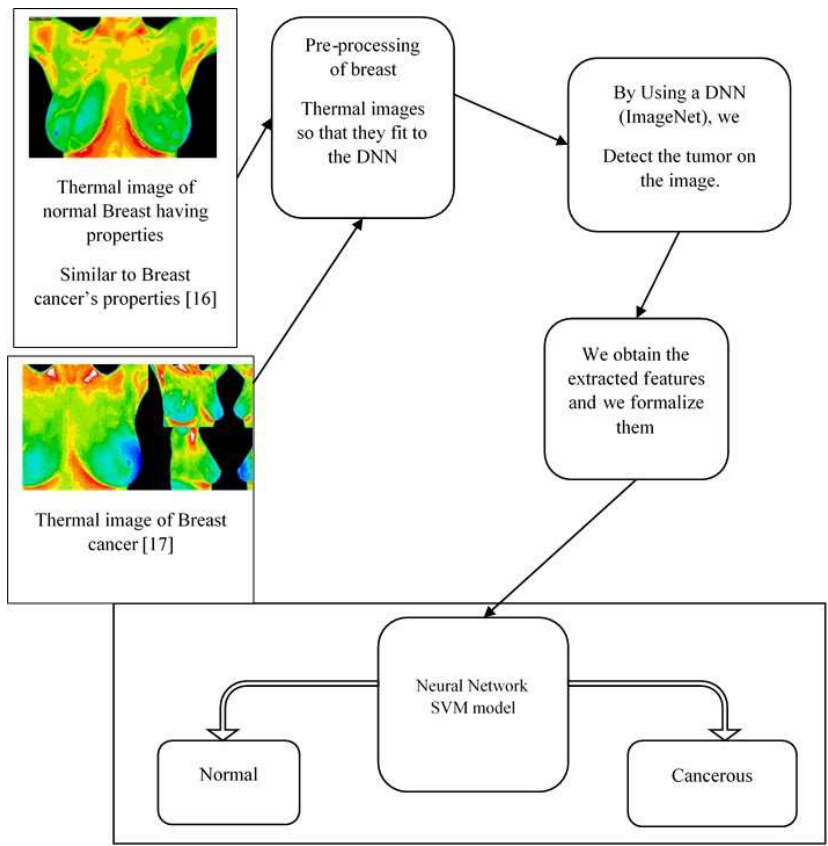
Figure 10. Illustration of our model [34].